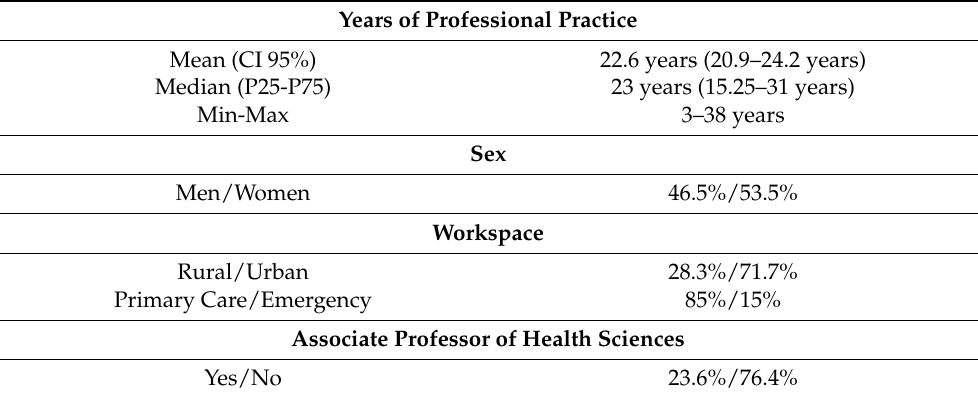
Table 1. Demographic and professional characteristics of